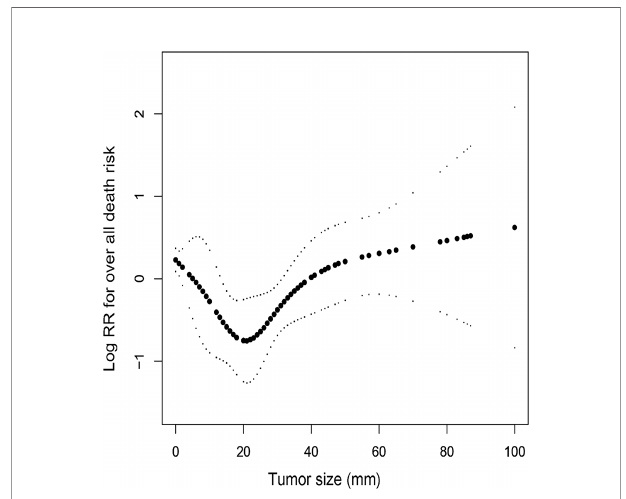
FIGURE 1 | Smooth curve fi tting showing the association between tumor size in millimeter and relative risk of overall death in parathyroid carcinoma patient population. The correlation between tumor size and overall death risk can be generalized as a U-shaped curve. The bottom of the curve represents parathyroid tumors with a diameter of 2 cm, and is where the risk of death reaches its lowest